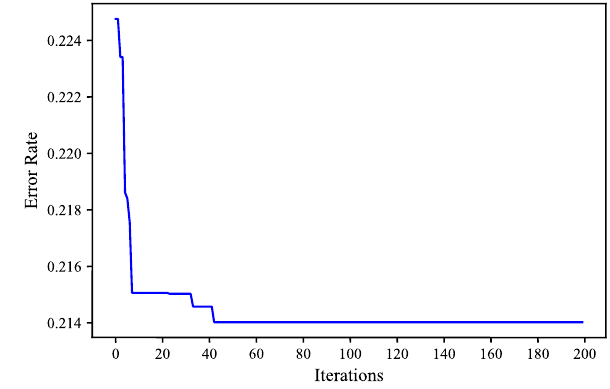
Fig. 8 Parameter optimization iteration of PSO-XGBoost